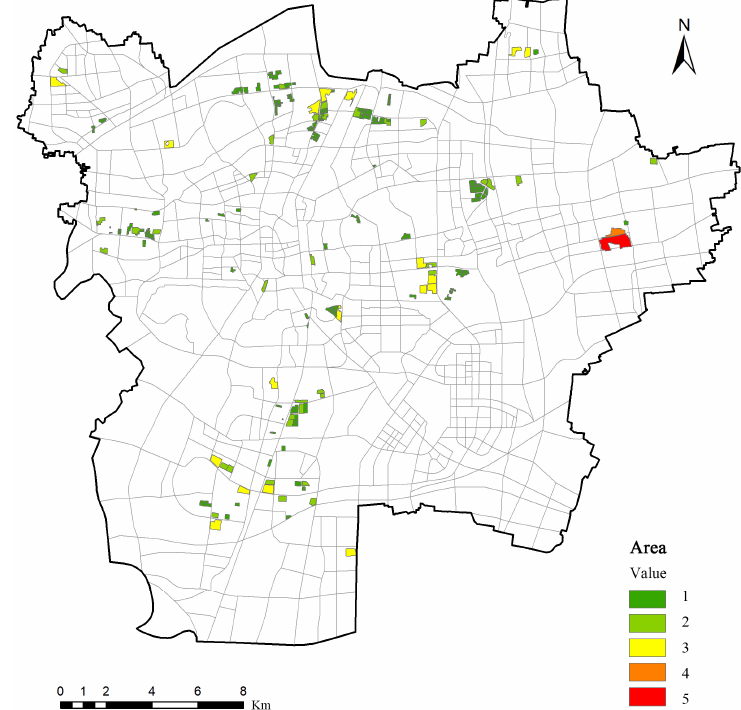
Figure A1. Single value of site suitability based on “area”.